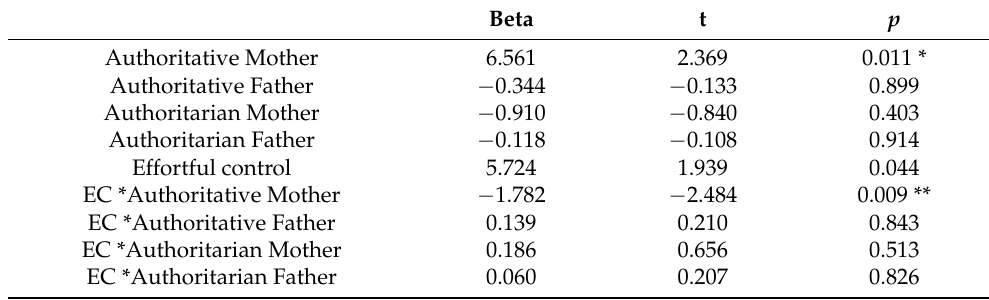
Table 5. Regression analysis for girls’ proactive aggression including parenting styles and effort- ful control.